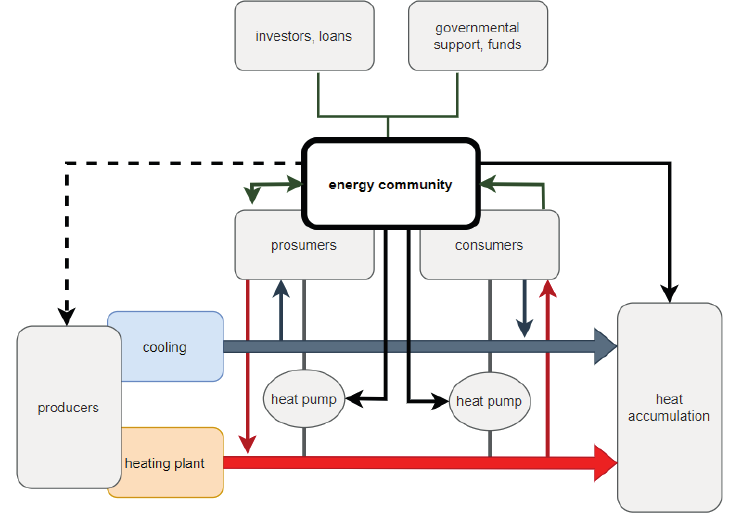
Fig. 5. Scheme of Scenario 3. Local Thermal Energy